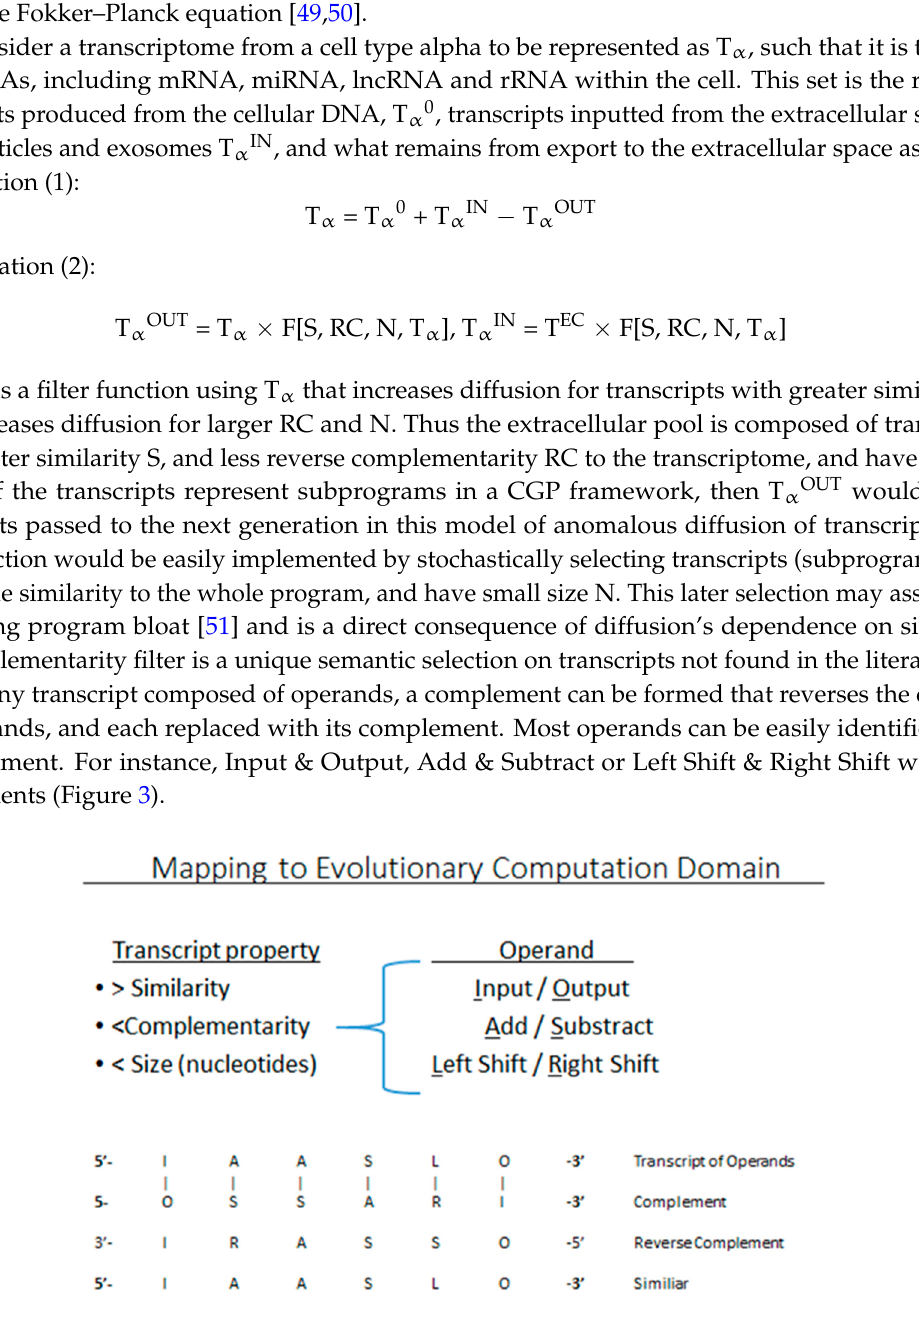
Figure 3. Mapping Anomalous diffusion to GP domain adding a pass-thru filter that operates semantically on information encoded as either RNA or lines of code in an evolvable subroutine.